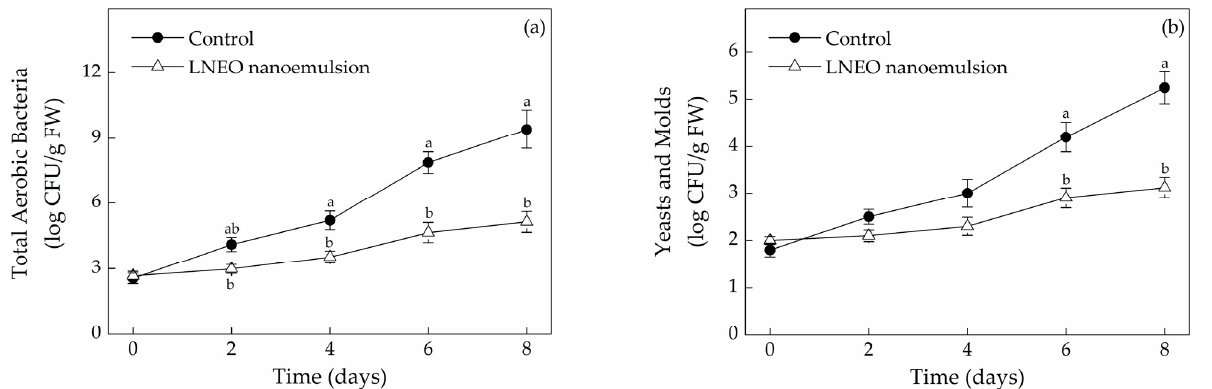
Figure 4. Effects of the LNEO nanoemulsion on the microbial growth (log CFU/g FW) in fresh-cut muskmelons: total aerobic bacteria ( a ); molds and yeasts ( b ). Data are the mean ± standard deviation (n = 3); a, b different letters denote sta- tistical